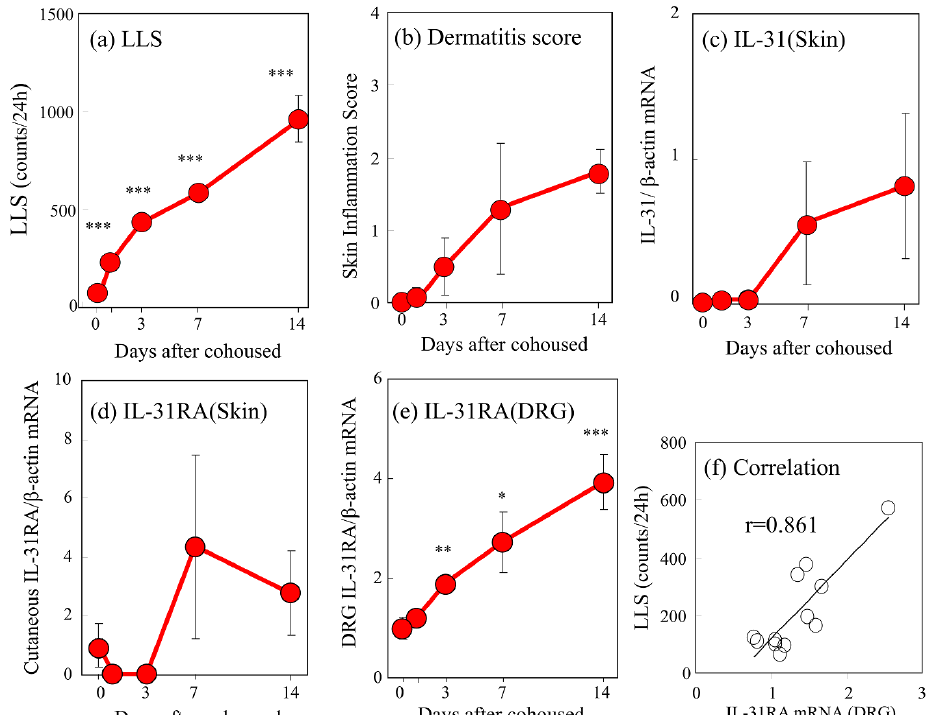
Figure 2. Time-course changes in long-lasting scratching (LLS), dermatitis score, cutaneous interleukin-31 (IL-31) and IL-31 receptor A (IL-31RA) mRNA expression, and dorsal root ganglion (DRG) neuronal IL-31RA mRNA expression in SPF-NC/Nga cohoused with skin-lesioned NC/Nga mice. ( a ) LLS (over 1.5 s) in NC/Nga mice was measured after 1–14 days. ( b ) Dermatitis score was based on the severity of erythema/hemorrhage, edema, excoriation/erosion, and scaling/dryness. ( c ) Cutaneous IL-31 mRNA/β-actin mRNA expression ratio. ( d ) Cutaneous IL-31RA mRNA/β-actin mRNA ratio. ( e ) DRG neuronal IL-31RA mRNA/β-actin mRNA expression ratio. ( f ) Correlation between the DRG neuronal IL-31RA mRNA expression ratio and the LLS counts in NC/Nga mice. Neuronal IL-31RA mRNA/β-actin mRNA expression ratio in SPF-NC/Nga mice cohoused with skin-lesioned NC/Nga mice for 3, 7. and 14 days was measured as described in the text. The values represent the means ± standard error (S.E.) from six mice. * p < 0.05, ** p < 0.01, *** p < 0.001 compared with pre-cohoused values of SPF-NC/Nga mice (Student’s t -test with Bonferroni correction).